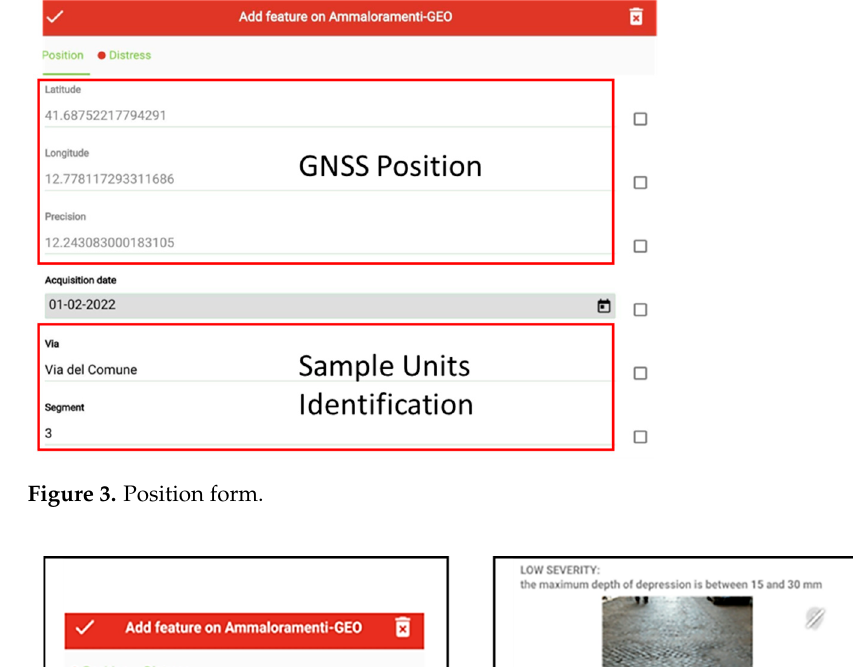
Figure 3. Position form.